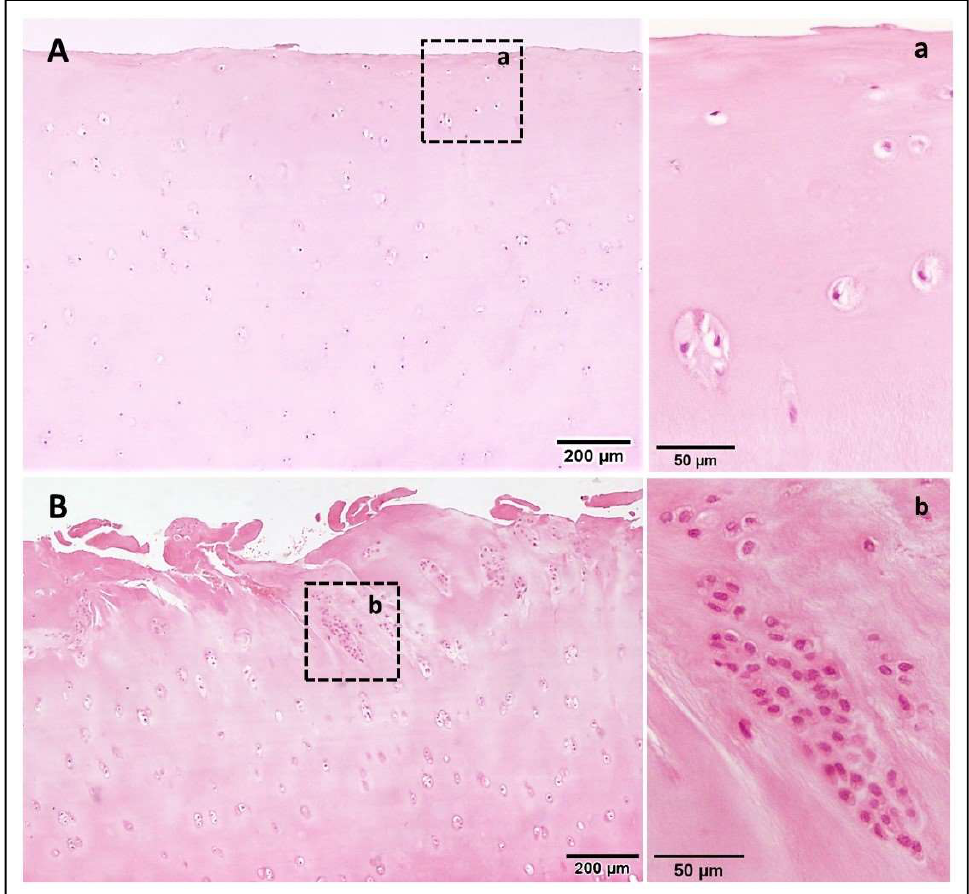
Figure 1. Haematoxylin and eosin staining of human N and OA cartilage. ( A ) Longitudinal section of N cartilage. ( a ) Detail of ( A ). ( B ) longitudinal section of OA cartilage. ( b ) Detail of ( B ) showing an example of chondrocyte clones.